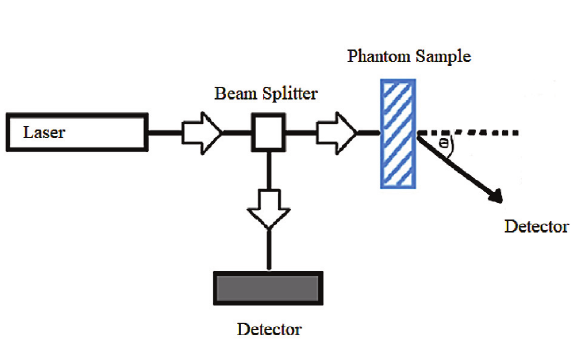
Fig. 1. Set-up for the measurement of optical